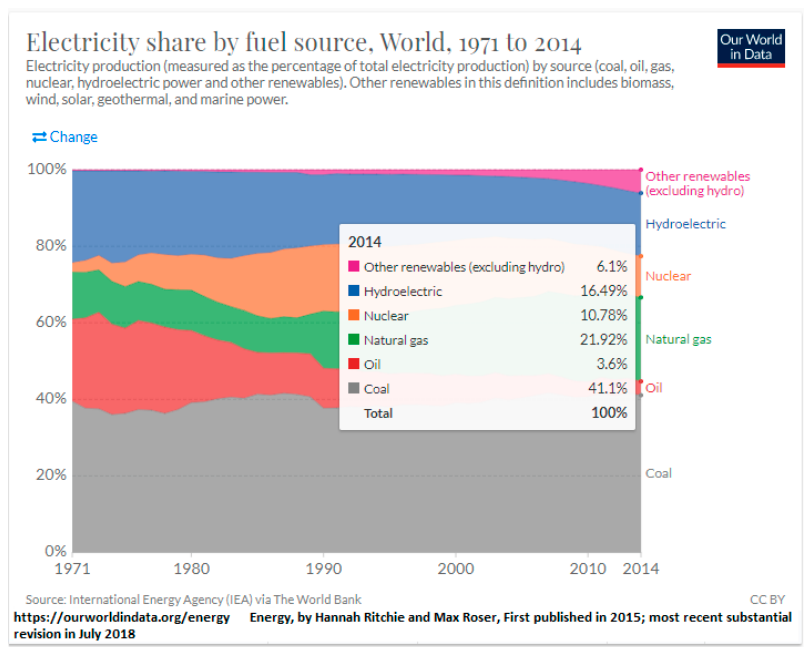
Figure 2. Global electricity production distribution.